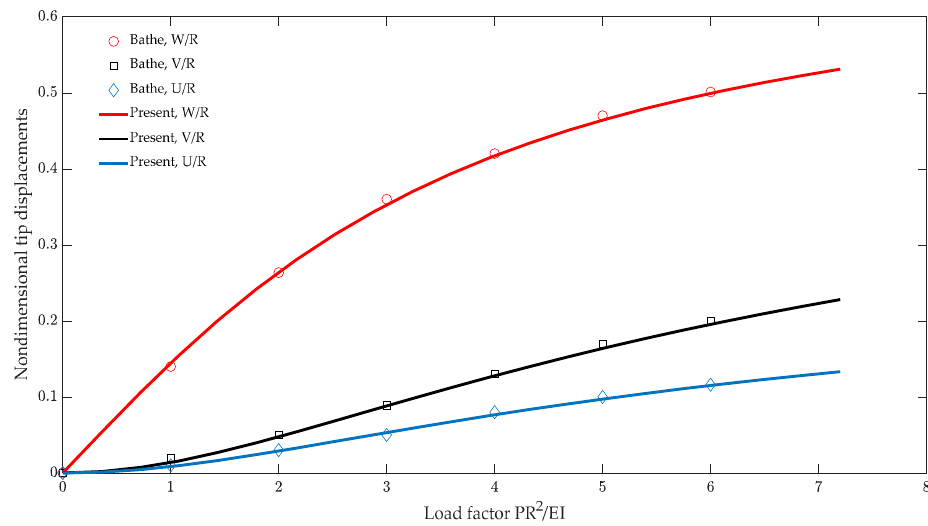
Figure 9. Load versus displacement curves of tip for the cantilever curved beam under an end force. Table 1. Free-end position of the cantilever 45-degree under out-of-plane force.